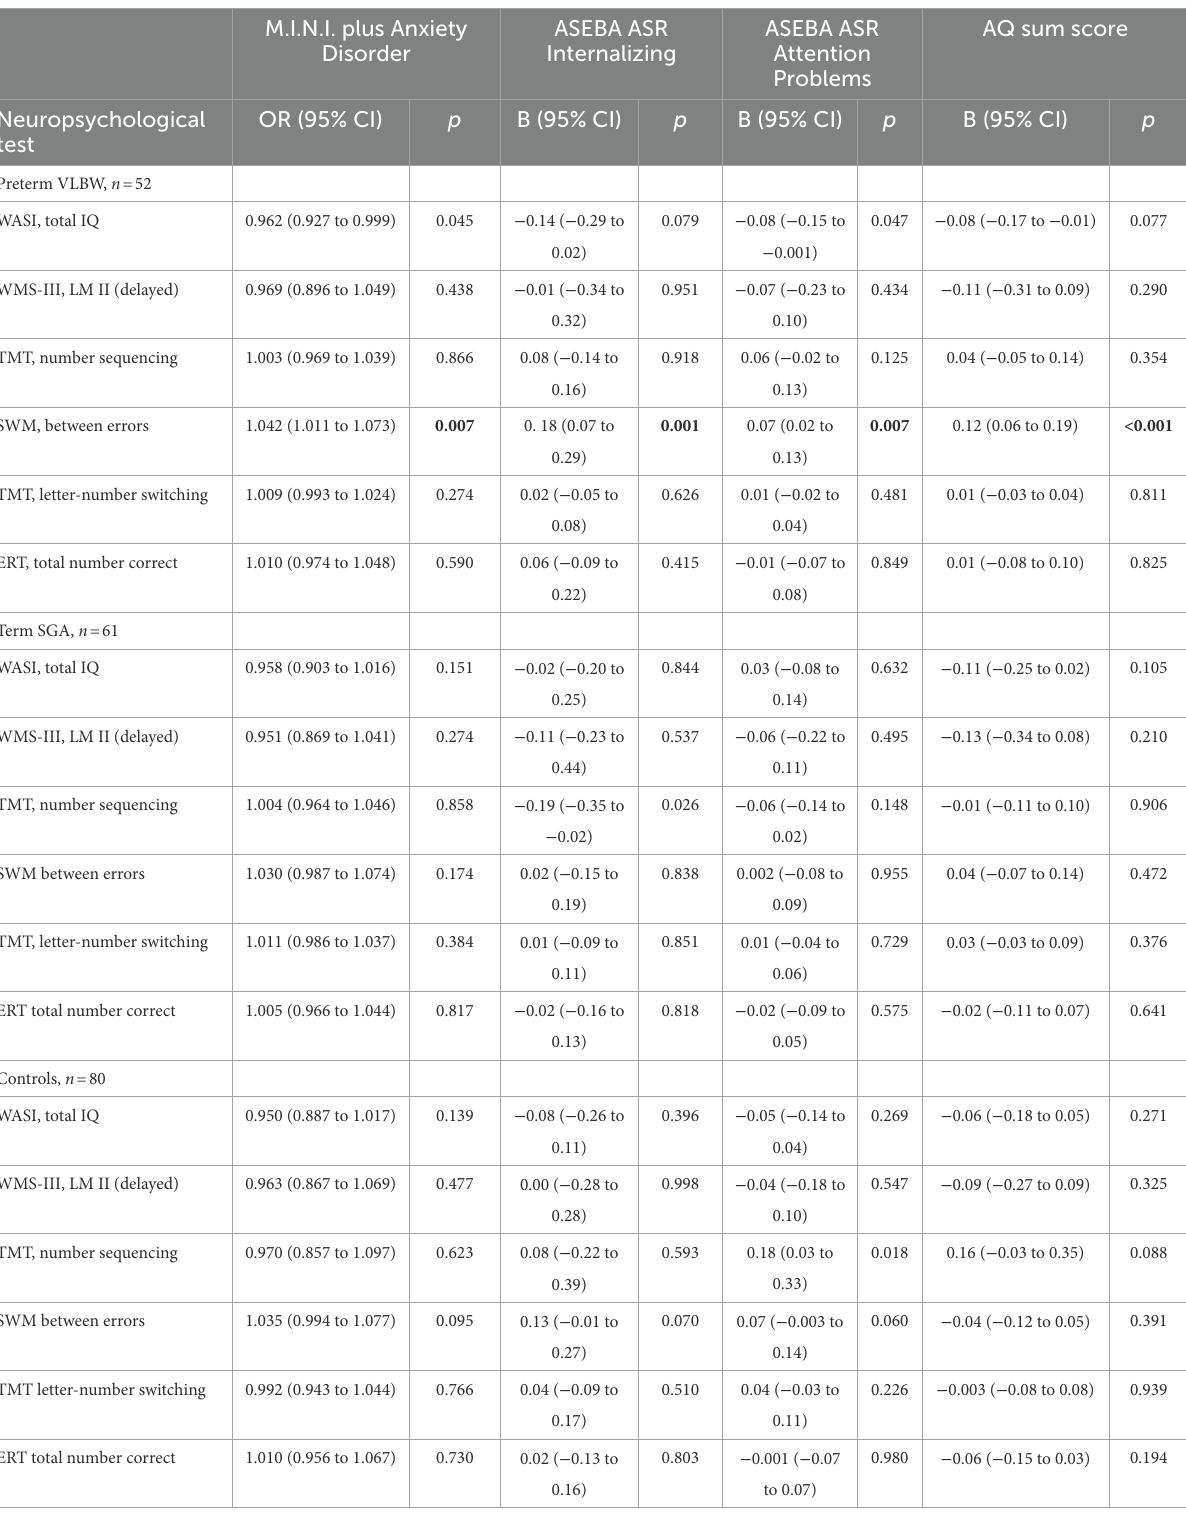
M.I.N.I. plus Anxiety Disorder